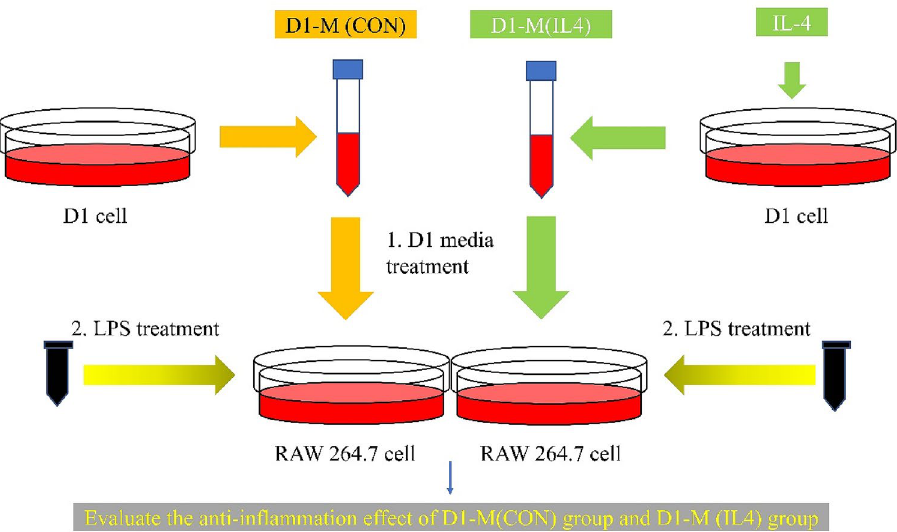
Figure 5. Procedure for the preparation of D1 cell media (D1-M) and the treatment of RAW264.7 cells. The D1 cells were stimulated with or without IL4 and incubated for 24 h, followed by media change and additional incubation for 24 h. After obtaining D1-M, RAW264.7 culture medium was replaced with a mixture of D1-M and complete media prepared at certain ratios (1:100, 1:10, 1:1, and 1) after incubation for 24 h, following the seeding of RAW264.7 cells. After media replacement, RAW264.7 cells were incubated with D1-M for 24 h, and LPS (working concentration: 200 ng/mL) was used to treat the RAW264.7 cells for the last 1, 6, and 22 h of incubation for different assays. D1-M (CON) represents D1 cell medium without IL4 treatment; D1-M (IL4) represents D1 cell medium stimulated with